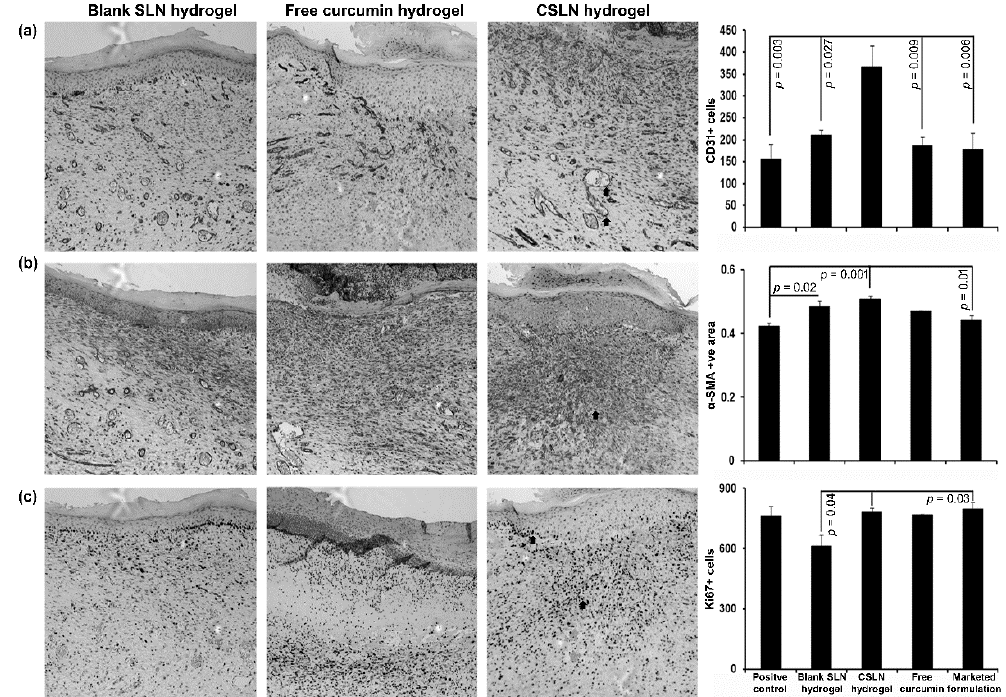
Figure 11. Effect of CSLNs on the angiogenesis (CD31), remodeling ( α -SMA), and proliferation (Ki67) in skin wound after healing at day 11. Representative images of blank SLN hydrogel, free curcumin hydrogel, and CSLN hydrogel are shown for different staining’s (top to bottom and left to right, respectively). Serial sections were stained separately with anti-CD31 ( a ), anti- α -SMA ( b ), and anti-Ki67 ( c ), and visualized with a 10X objective. The number of +Ve cells/area obtained by ImageJ analysis were compared between all the groups (right panel, top to bottom). Data are represented as mean ± SEM. Statistical significance was determined by ANOVA followed by Tukey HSD. Arrows indicate +Ve cells for respective staining. Table 10. Antimicrobial effect of CSLNs against Staphylococcus aureus ATCC 9144.